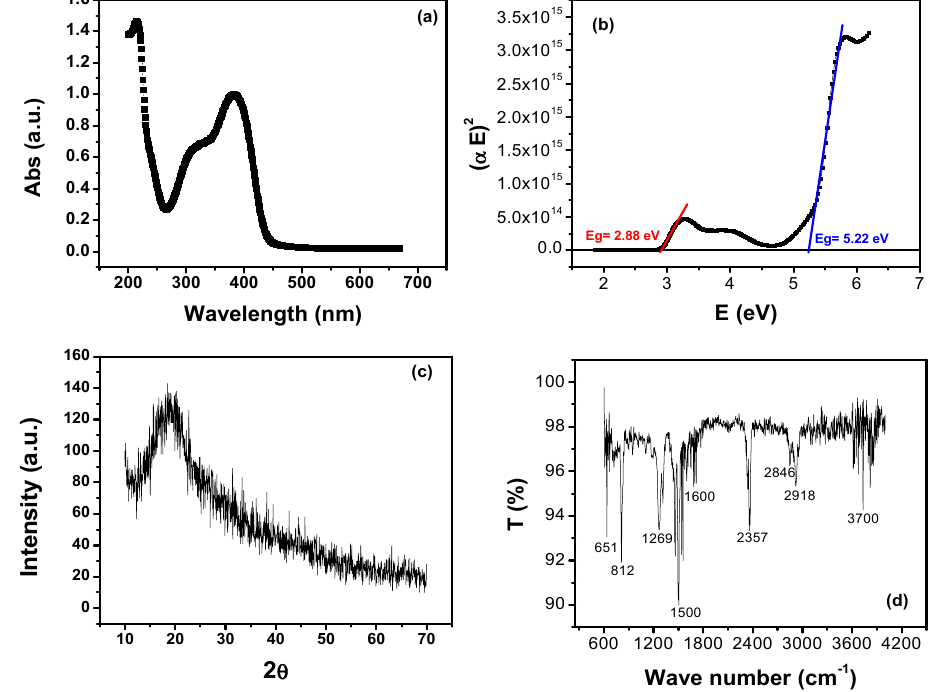
Figure 3. ( a ) UV–vis absorption spectrum, ( b ) Tauc’s plot for bandgap measurement, ( c ) XRD diffractogram, and ( d ) FTIR spectrum of PFB thin film.